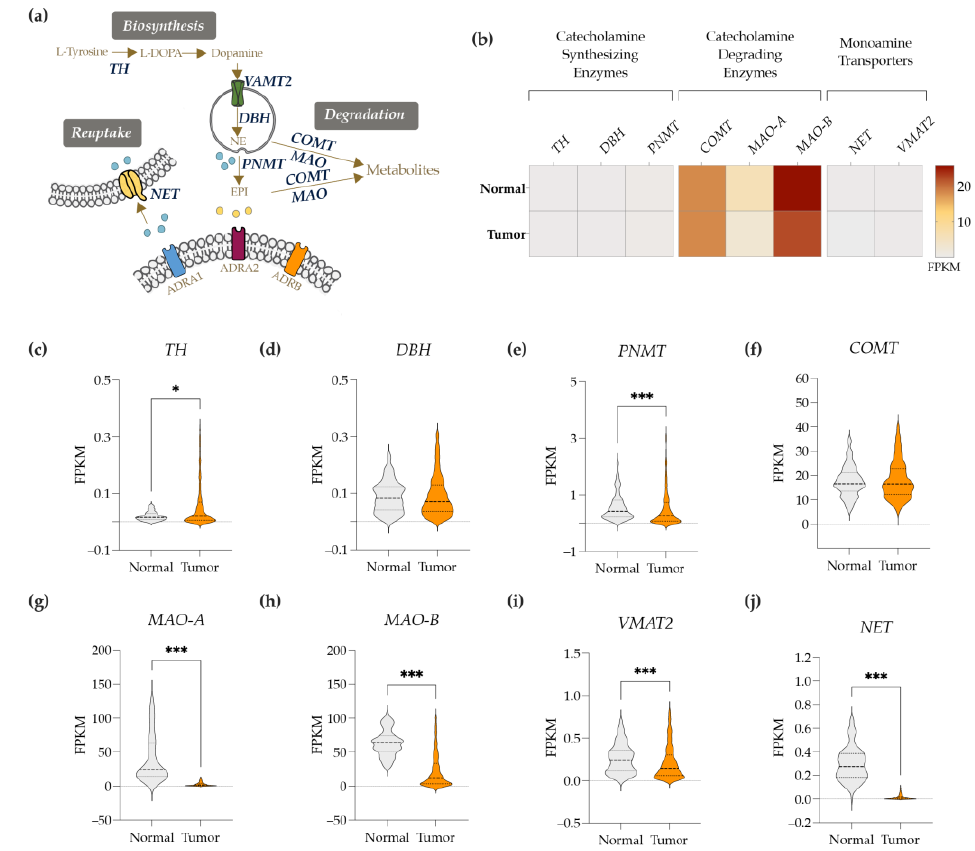
Figure 5. Gene expression profile of enzymes involved in catecholamine biosynthesis, degradation, and transportation in BC (using the BC dataset included in the TCGA database). ( a ) Diagram explaining the metabolism cascade of the catecholamines. ( b ) Heatmap of the expression markers of catecholamine metabolism. ( c – j ) Charts comparing normal versus BC tissues for each marker of catecholamine metabolism are illustrated ( b – j ). p -value < 0.05 (*), <0.01 (**), <0.001 (***) was considered statistically significant. Table 3. Pearson’s correlation between the gene expression of ADRs and markers of catecholamine metabolism in the BC tissues (dataset obtained from TCGA database).